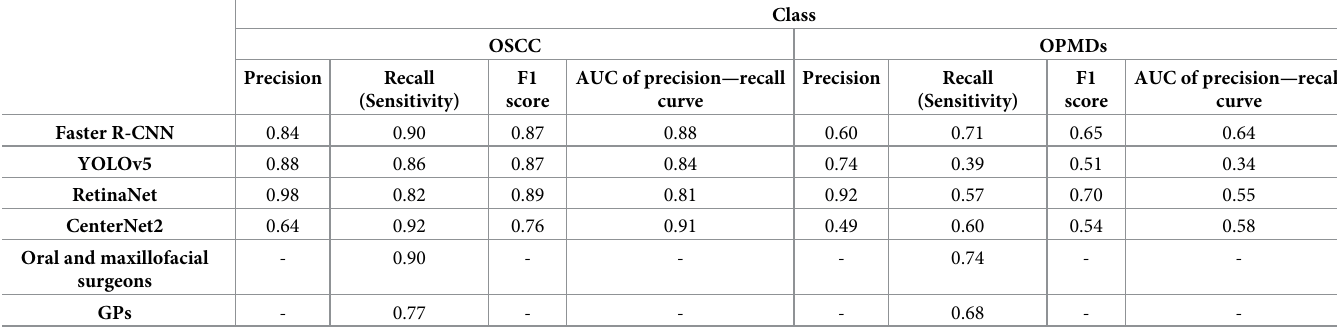
Table 2. Multi-class object detection performances of CNN algorithms on the test